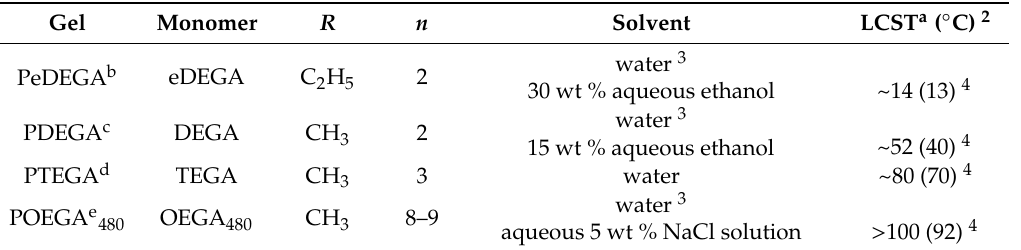
Table 1. Preparation of porous thermosensitive gels. 1